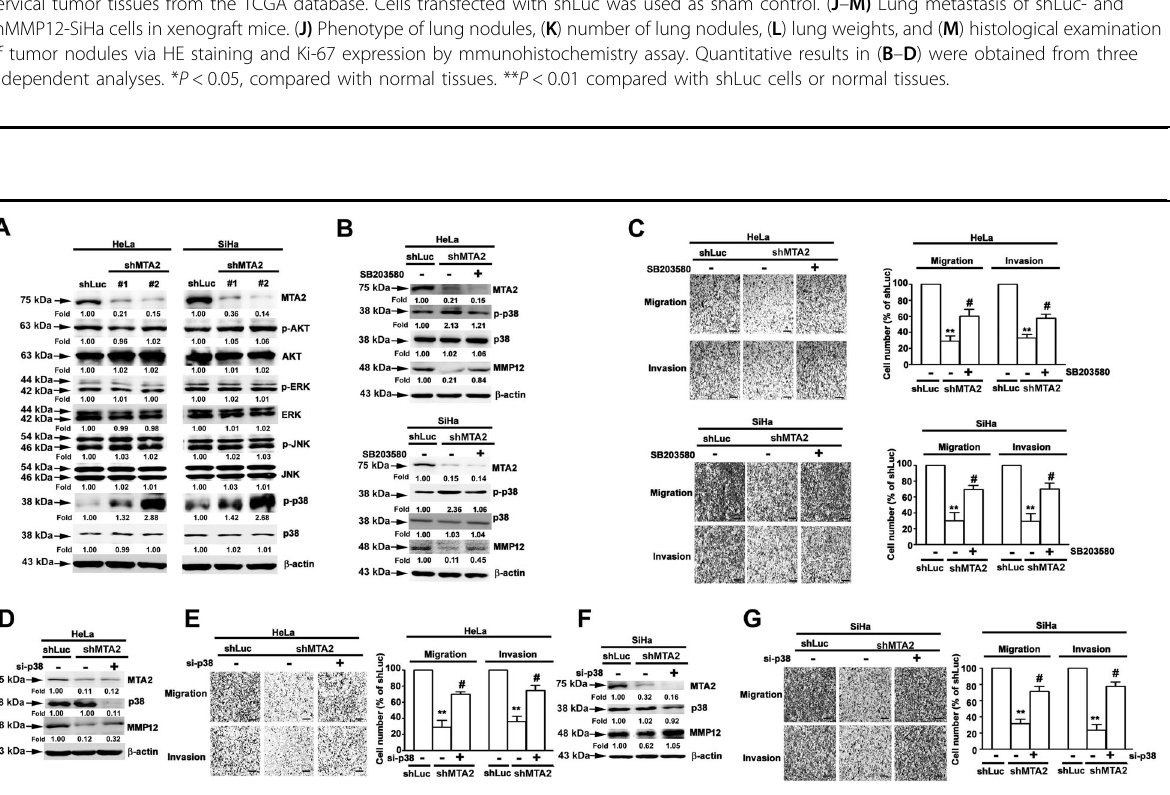
Fig. 3 Involvement of p38 signaling in the downregulation of MMP12 in MTA2-knockdown cervical cancer cells. (A) Cells were transfected with shRNA against MTA2 (shMTA2) and then lysed for immunodetection of AKT and MAPK activation. ( B , C) Cells were transfected with shMTA2, treated with the p38 inhibitor SB203580, and then subjected to ( B ) immunodetection of p38 activation and MMP12 expression or ( C ) migration and invasion assay. ( D – G) Cells were transfected with shMTA2 and siRNA against p38 (si-p38) and then subjected to ( D , F ) immunodetection of MTA2, p38, and MMP12 and ( E , G ) migration and invasion assay. β -actin signal was used as internal control. ** and #, P < 0.01 and P < 0.05 compared with shLuc and shMTA2 cells alone,